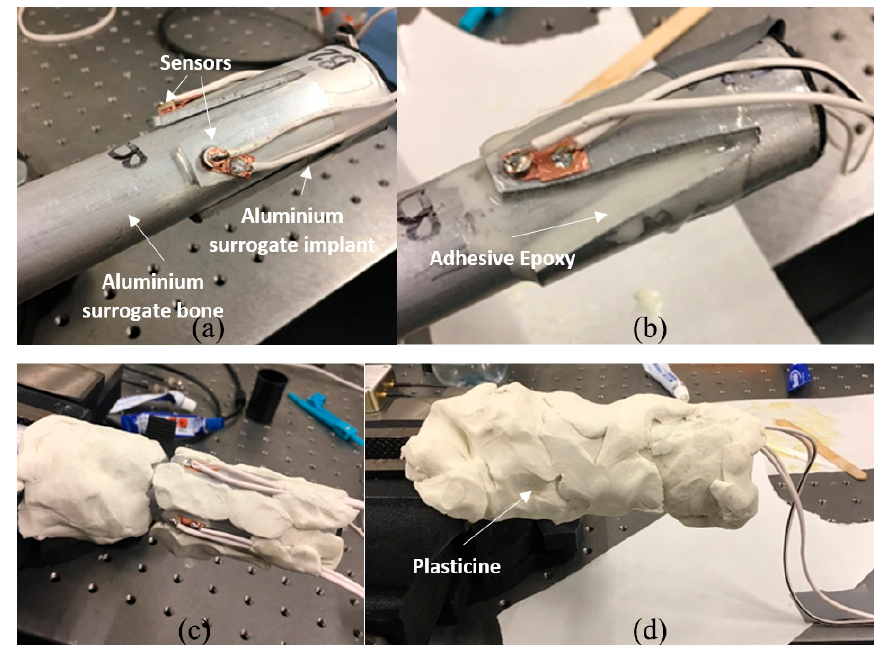
Table 1. Oval and triangular cross-section specimens’ masses.